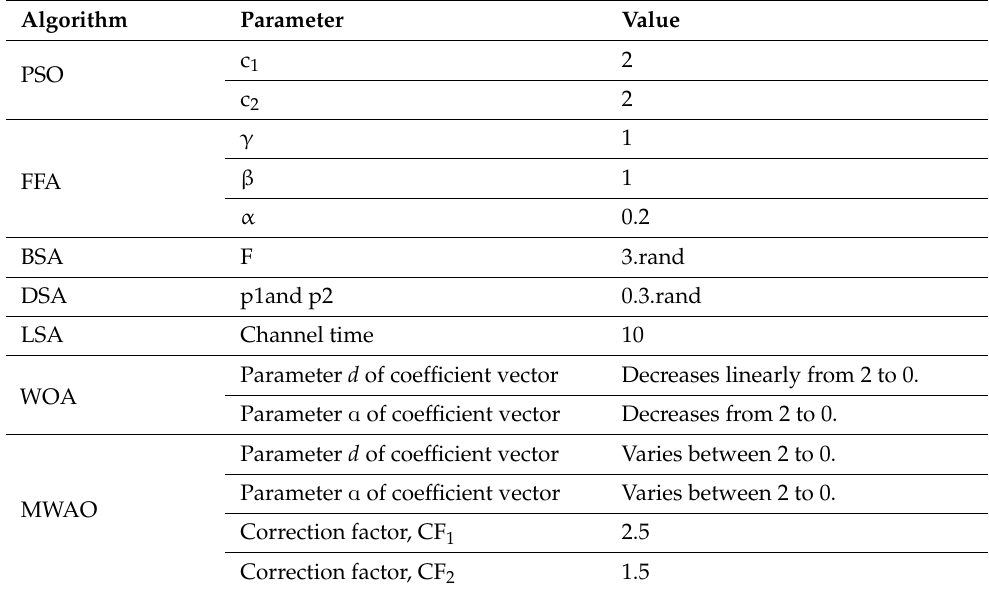
Table A4. Parameters setup of various metaheuristic